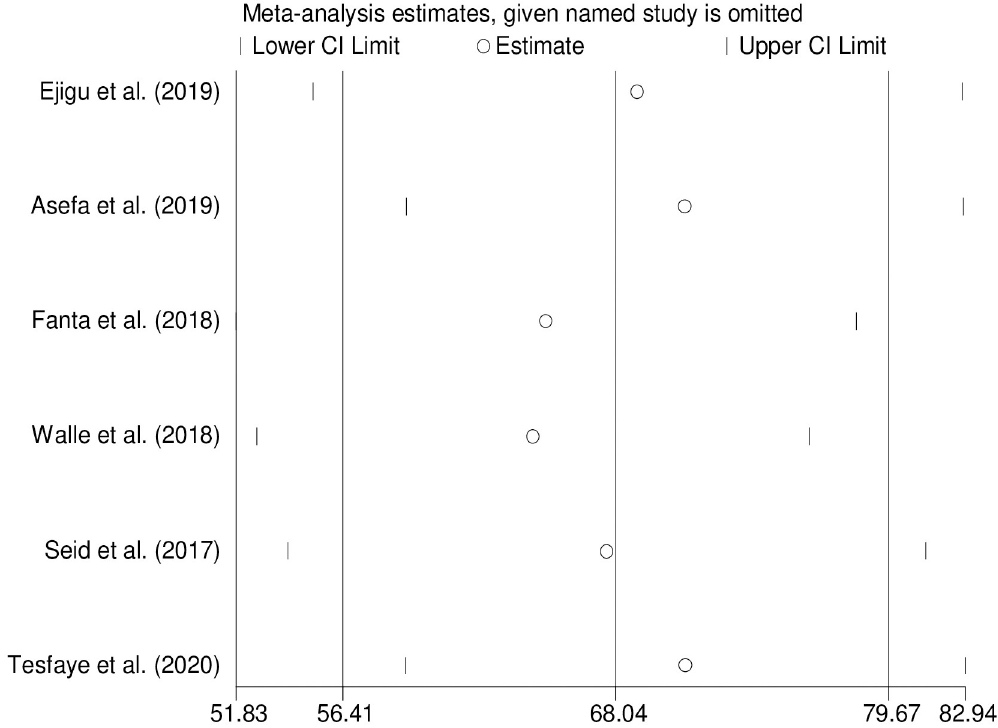
Fig 3. Plot of sensitivity analysis to assessing the influence of individual